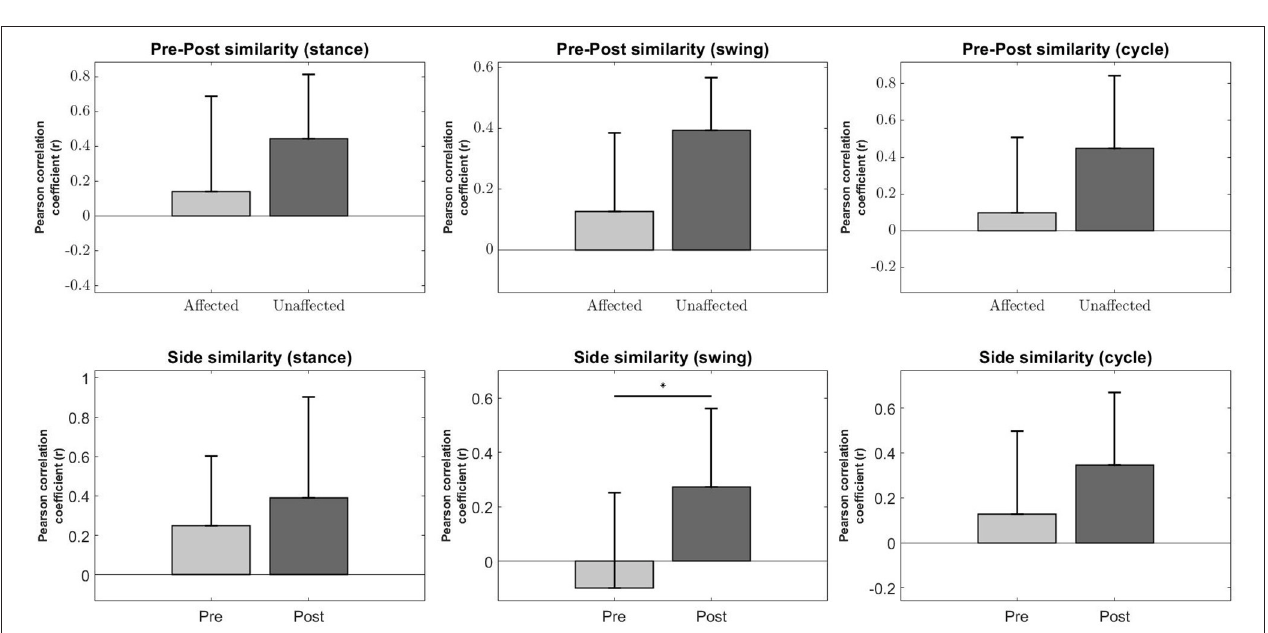
FIGURE 7 | Raw EMG waveform and joint angles, post intervention. Positive values in angles indicate joint flexion, while negative values indicate extension.